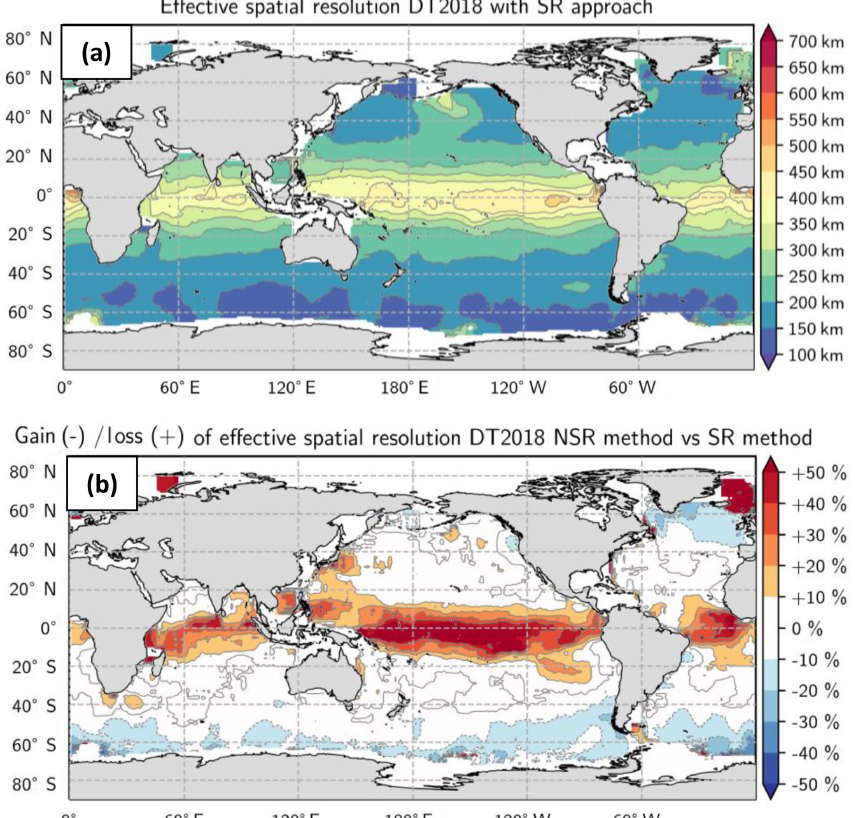
Figure A2. (a) DUACS-DT2018 useful resolution derived from spectral ratio (SR) approach and (b) ratio of effective to useful resolution for the DT2018 maps. Blue means finer resolution with